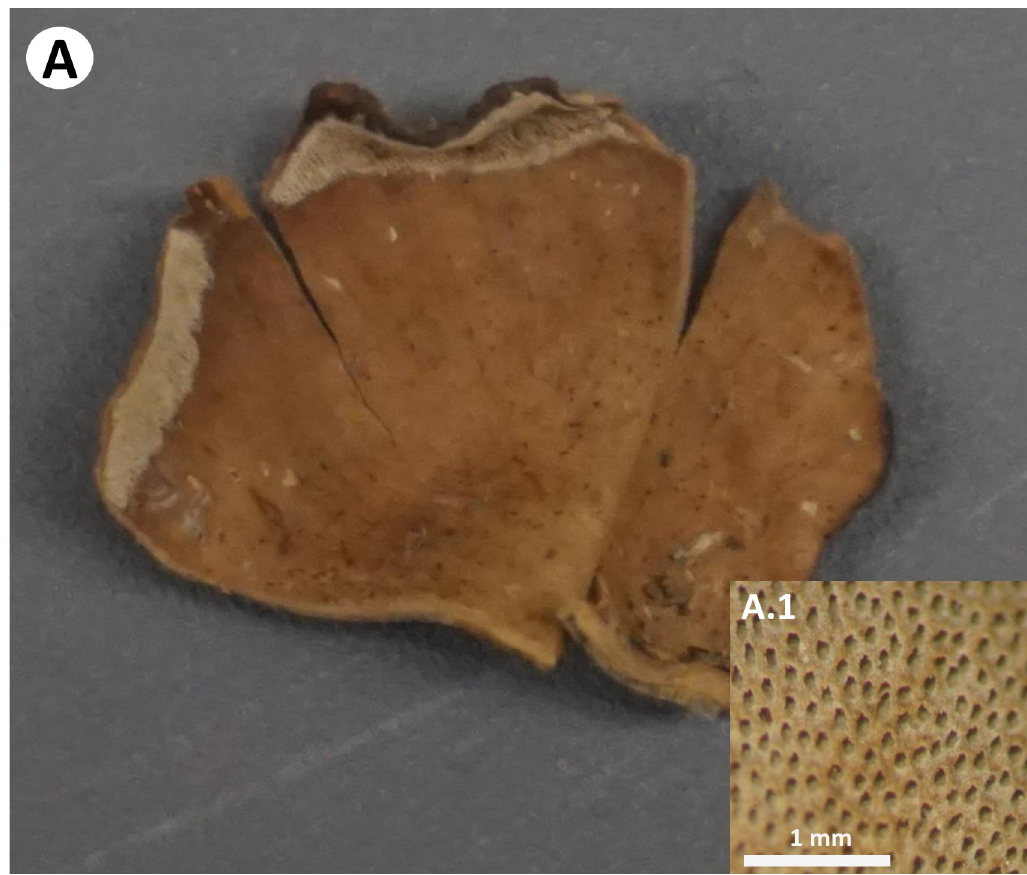
Fig 10. Basidiomata of Polyporus leprieurii , BZ-958. A. Dried basidiome. A1 Pore